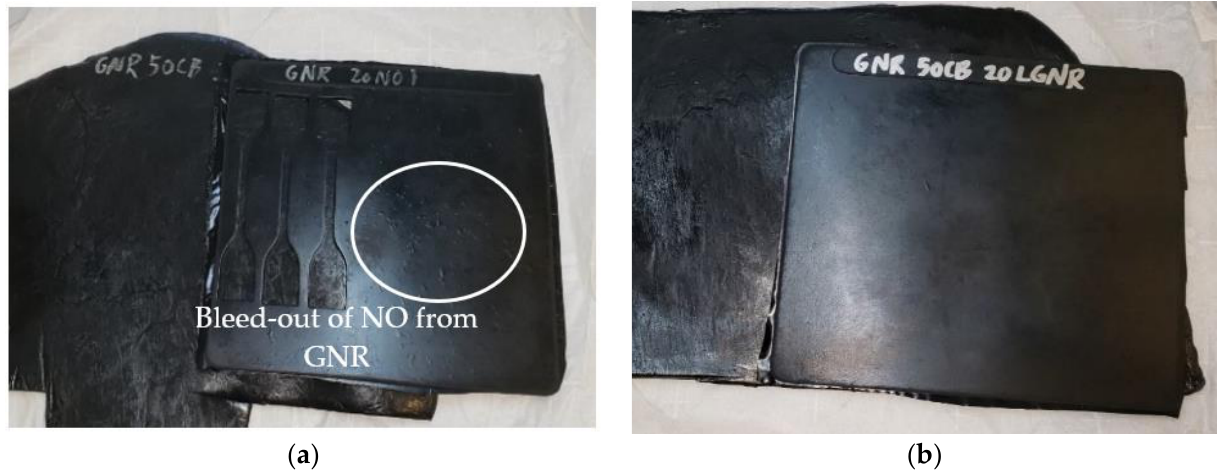
Figure 4. Cured guayule natural rubber (GNR) composites: ( a ) with 10 phr naphthenic oil; and ( b ) with 10 phr liquid guayule natural rubber.